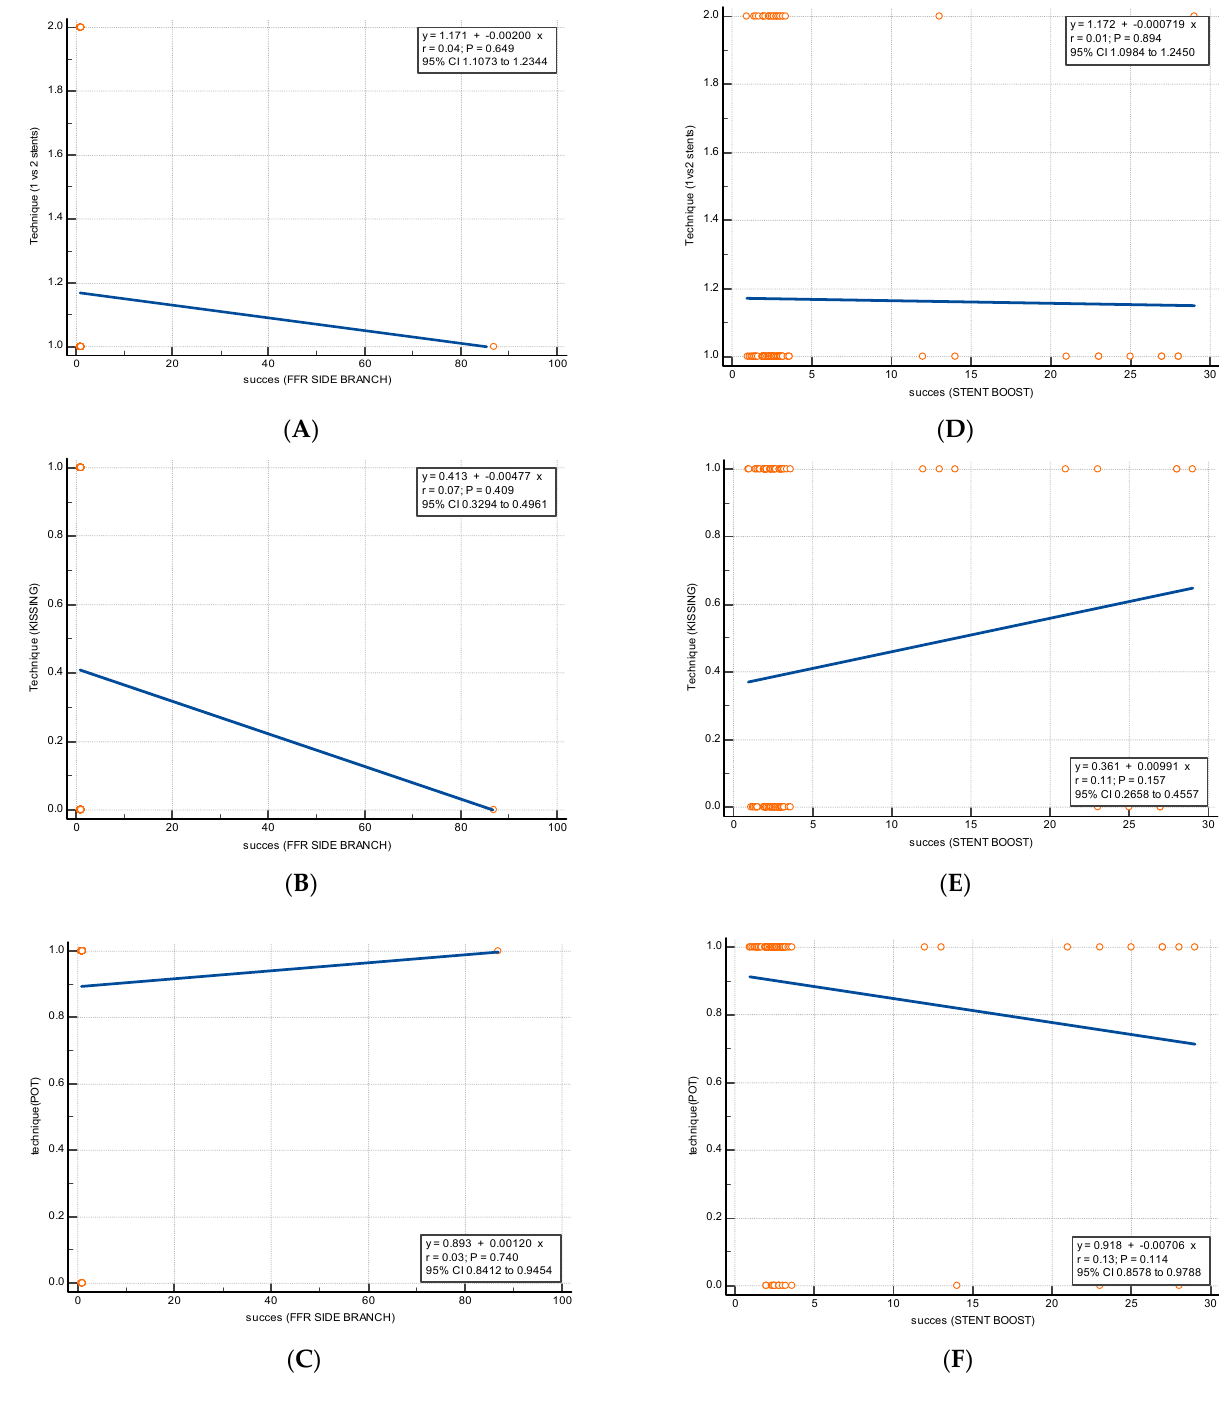
Figure 1. Regression analysis for each technique and success criteria. ( A ) Technique—one ‐ vs. two ‐ stent technique; success—FFR side branch > 0.8 (Standard error of the slope = 0.004, p = 0.65). ( B ). Technique—kissing ‐ balloon inflation; success—FFR side branch > 0.8 (Standard error of the slope = 0.006, p = 0.41). ( C ) Technique—POT; success—FFR side branch > 0.8 (Standard error of the slope = 0.0036, p = 0.74). ( D ). Technique—one ‐ vs. two ‐ stent technique; success—SESBL > 2 (Standard error of the slope = 0.0053, p = 0.89). ( E ) Technique—kissing ‐ balloon inflation; suc ‐ cess—SESBL > 2 (Standard error of the slope = 0.0069, p = 0.16). ( F ) Technique—POT; suc ‐ cess—SESBL > 2 (Standard error of the slope = 0.0044, p = 0.12). FFR, fractional flow reserve; POT, proximal optimization technique.